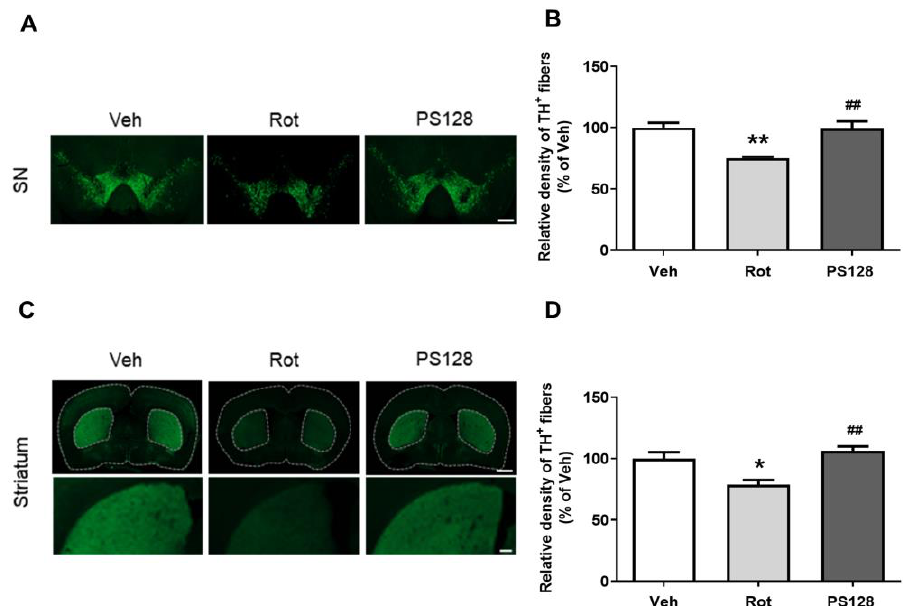
Figure 2. L. plantarum PS128 attenuated the reduction of tyrosine hydroxylase-positive (TH + ) dopaminergic neurons in rotenone-induced PD-like mice. ( A , C ) Representative images of TH immunostaining in the substantia nigra (SN) and striatum of mice, respectively. ( B , D ) Quantitative analysis of the density of TH + immunostaining in the SN and striatum of mice, respectively. N = 5 per group, * p < 0.05, ** p < 0.01 compared with the Veh group; ## p < 0.01 compared with the Rot group. Scale bar = 500 μm in ( A ); scale bar = 1 mm and 200 µm on the top and bottom panel of ( C ), respectively.